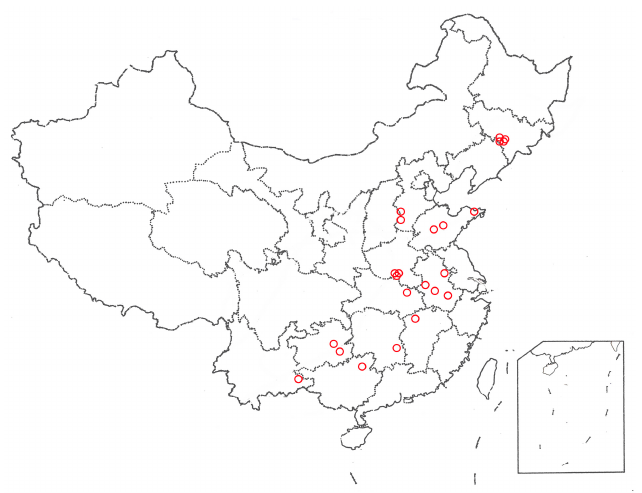
Figure 5. PR sampling locations in different regions in China.